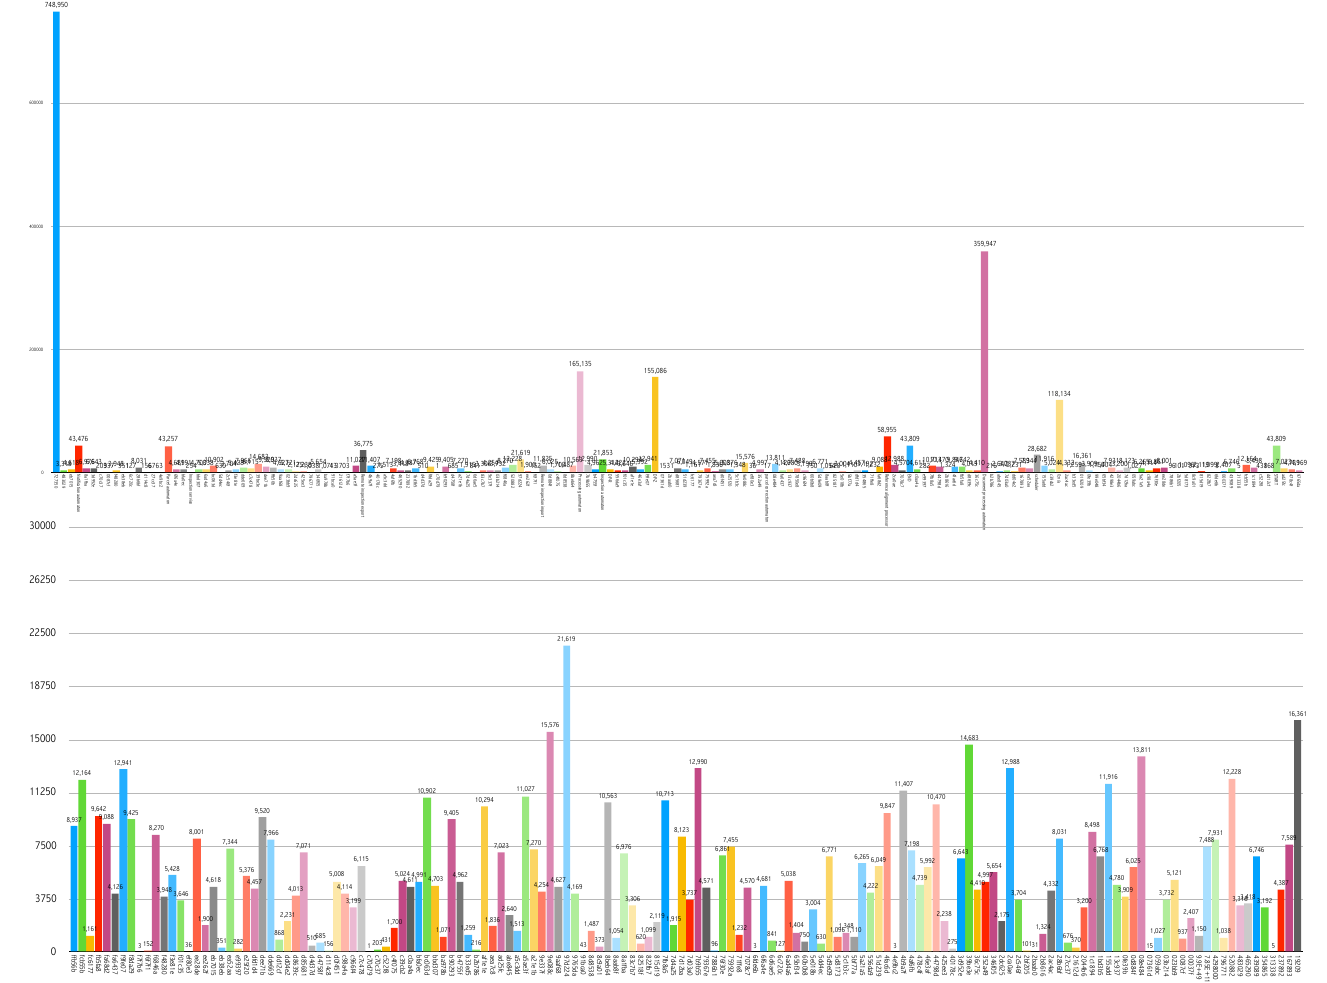
Figure 9. ( a ) Measured occurrences of all the performers and ( b ) the part of the measurement results, centered on the performer group with moderate